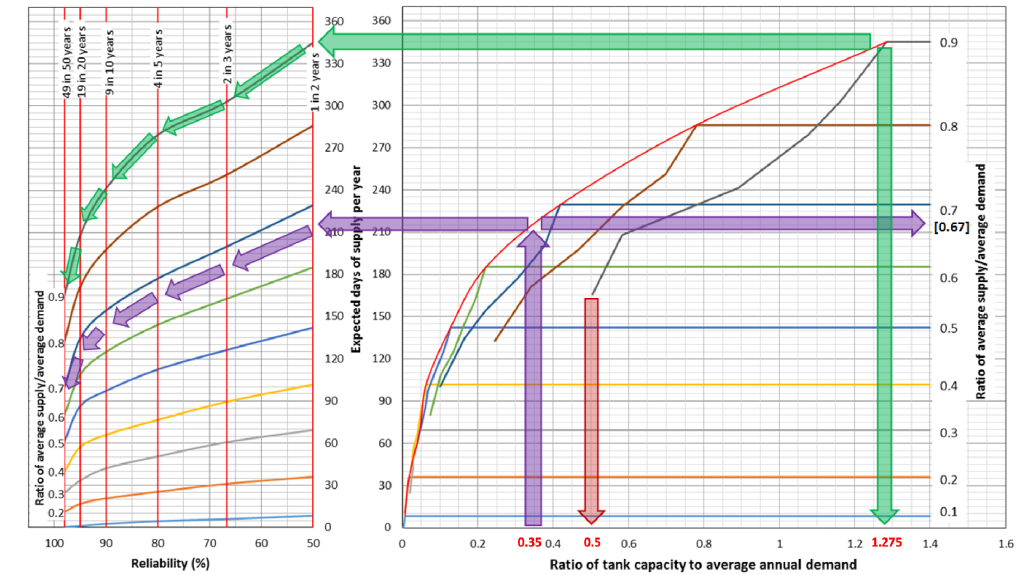
Figure 5. Example of application of rainwater harvesting sizing and assessment